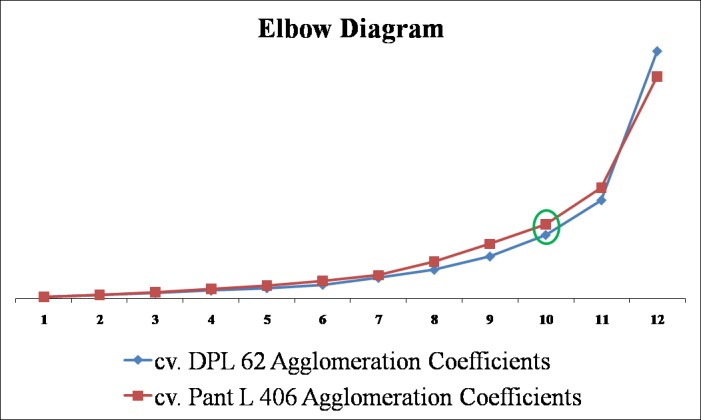
Agglomerative graph of two lentil cultivars for determining number of clusters.